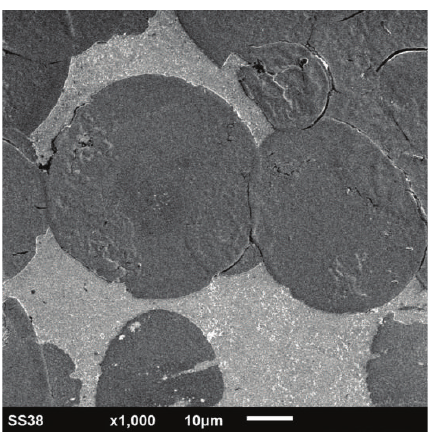
Figure 2: SEM surface image of sprayed TiO x droplets on glass/FTO substrate.